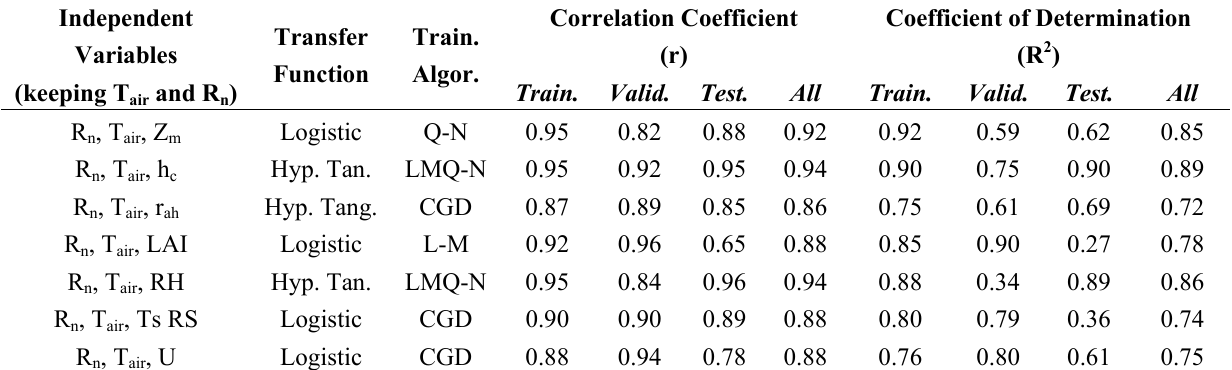
Table 4. Performance of ANN using combinations of three independent